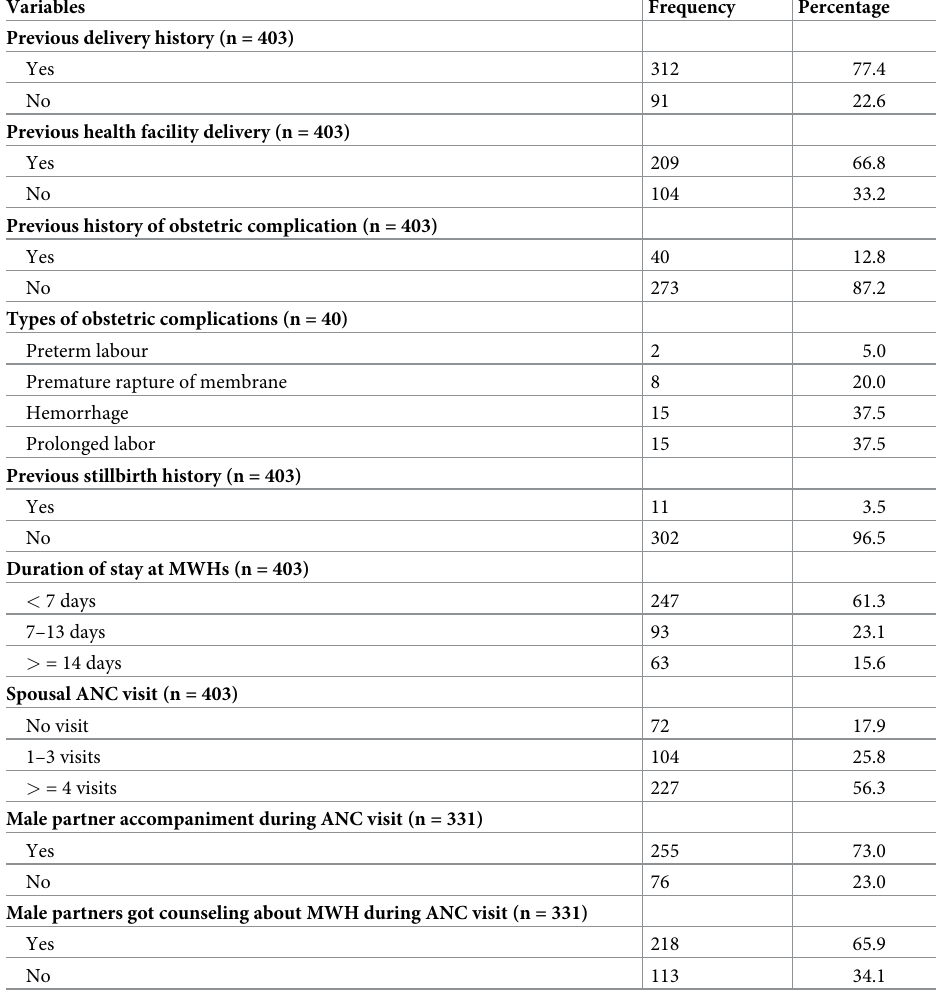
Table 2. Study participant’s spousal obstetric history in North Achefer district, 2018.